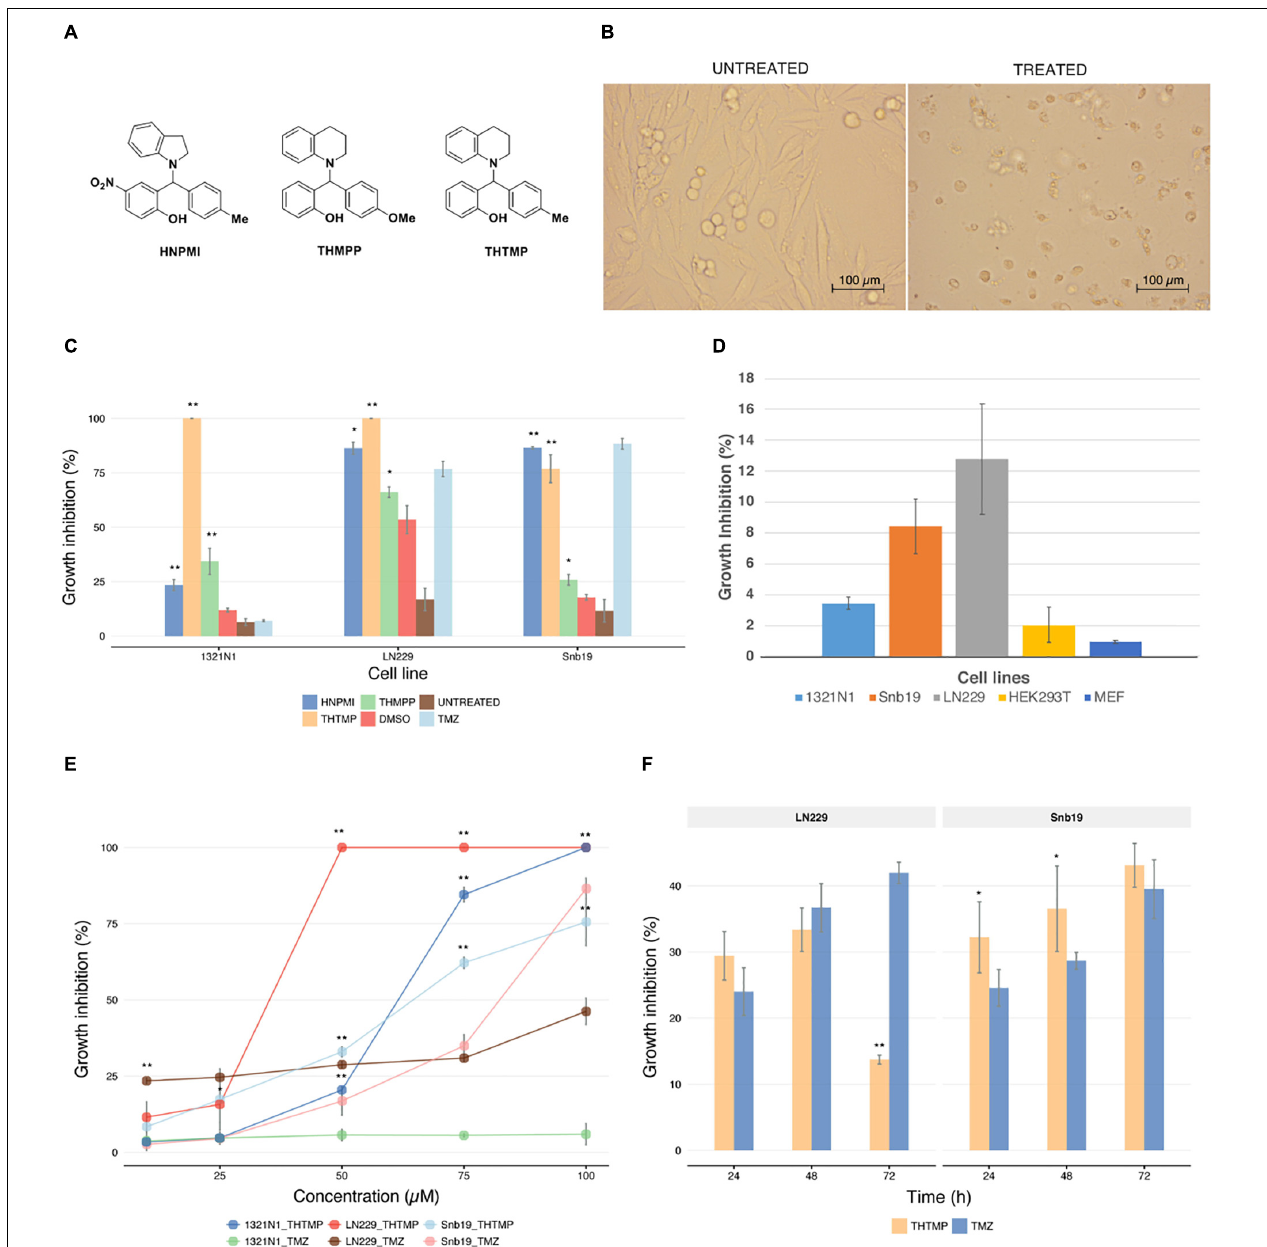
FIGURE 1 | Effect of alkylaminophenols characterized by cell growth arrest. (A) Molecular structure of three tested phenolic compounds (HNPMI, THMPP, and THTMP). (B) Demonstrated images of morphological changes in GBM cells at 24 h after treatment. (C) Cell growth inhibition was determined with trypan blue solution for compounds HNPMI, THMPP, THTMP, and TMZ against GBM cells (1321N1, LN229, and Snb19) at 100 µ M concentration. (D) Growth inhibitory effect of THTMP on different cell lines 1321N1, LN229, and Snb19 and HEK293T cells at 10 and 100 µ M at 24 h post-treatment. (E) Effect of THTMP and TMZ on GBM cell growth. Different concentrations including 10, 25, 50, 75, and 100 µ M were utilized and incubated for 24 h. (F) Time-dependent effect of THTMP and TMZ on LN229 and Snb19 at 24, 48, and 72 h post-treatment at IC50 concentrations. All experiments were performed with three biological repeats and two technical repeats. ∗∗ P < 0.001, ∗ P < 0.05 compared to the